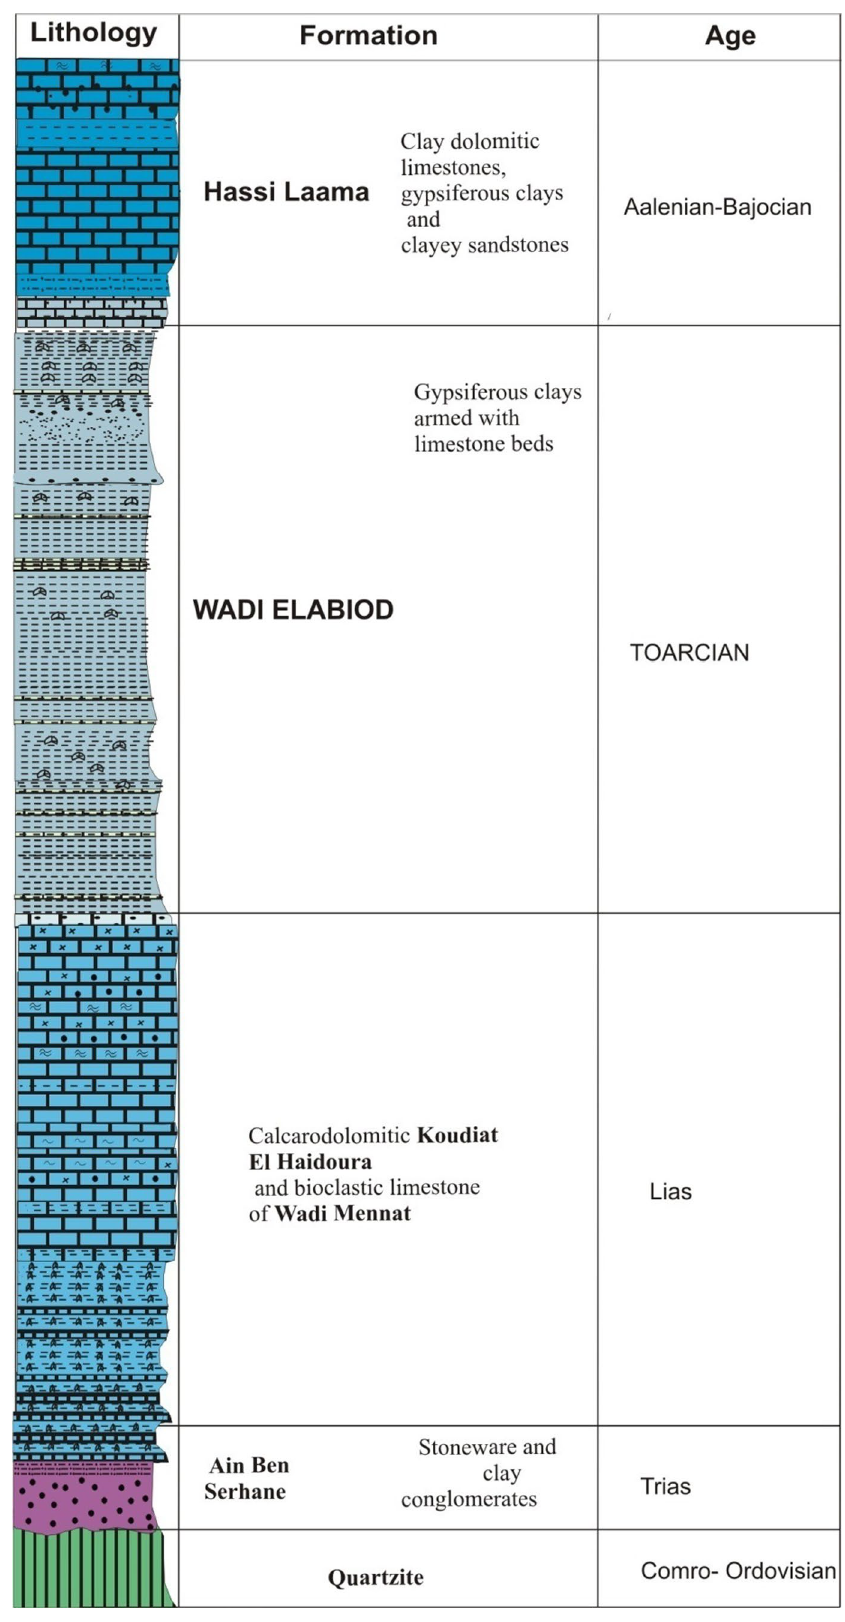
Fig. 2 Aquifer system in